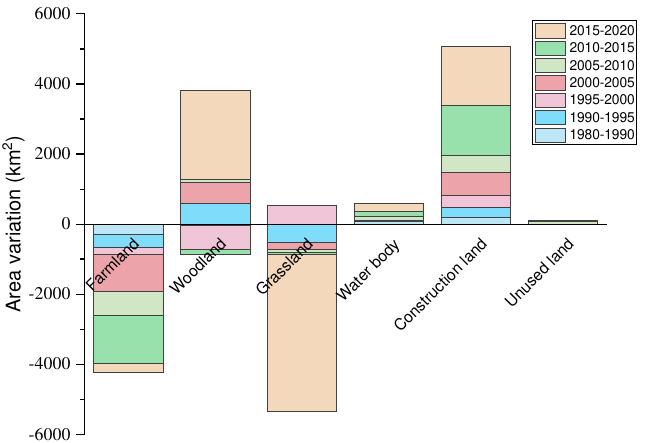
Figure 3. Statistics of area variation of land-use types.